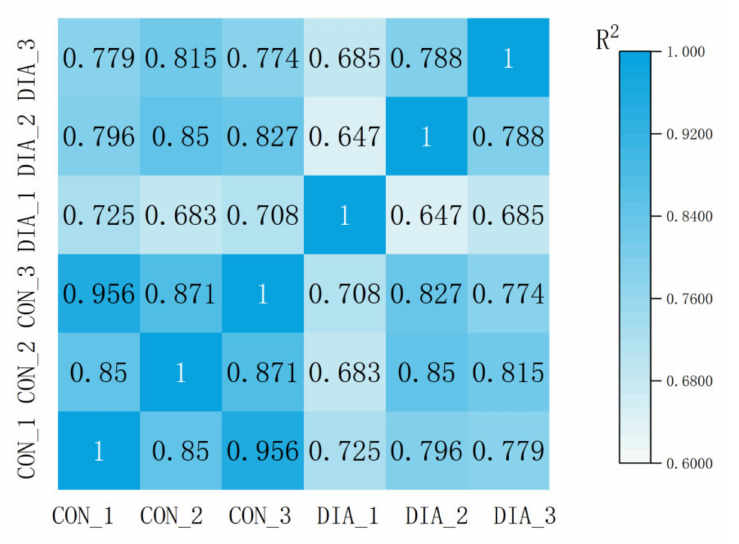
Figure 4. Heat map of correlation analysis between samples. The higher the correlation coefficient between samples, the closer the expression pattern is.